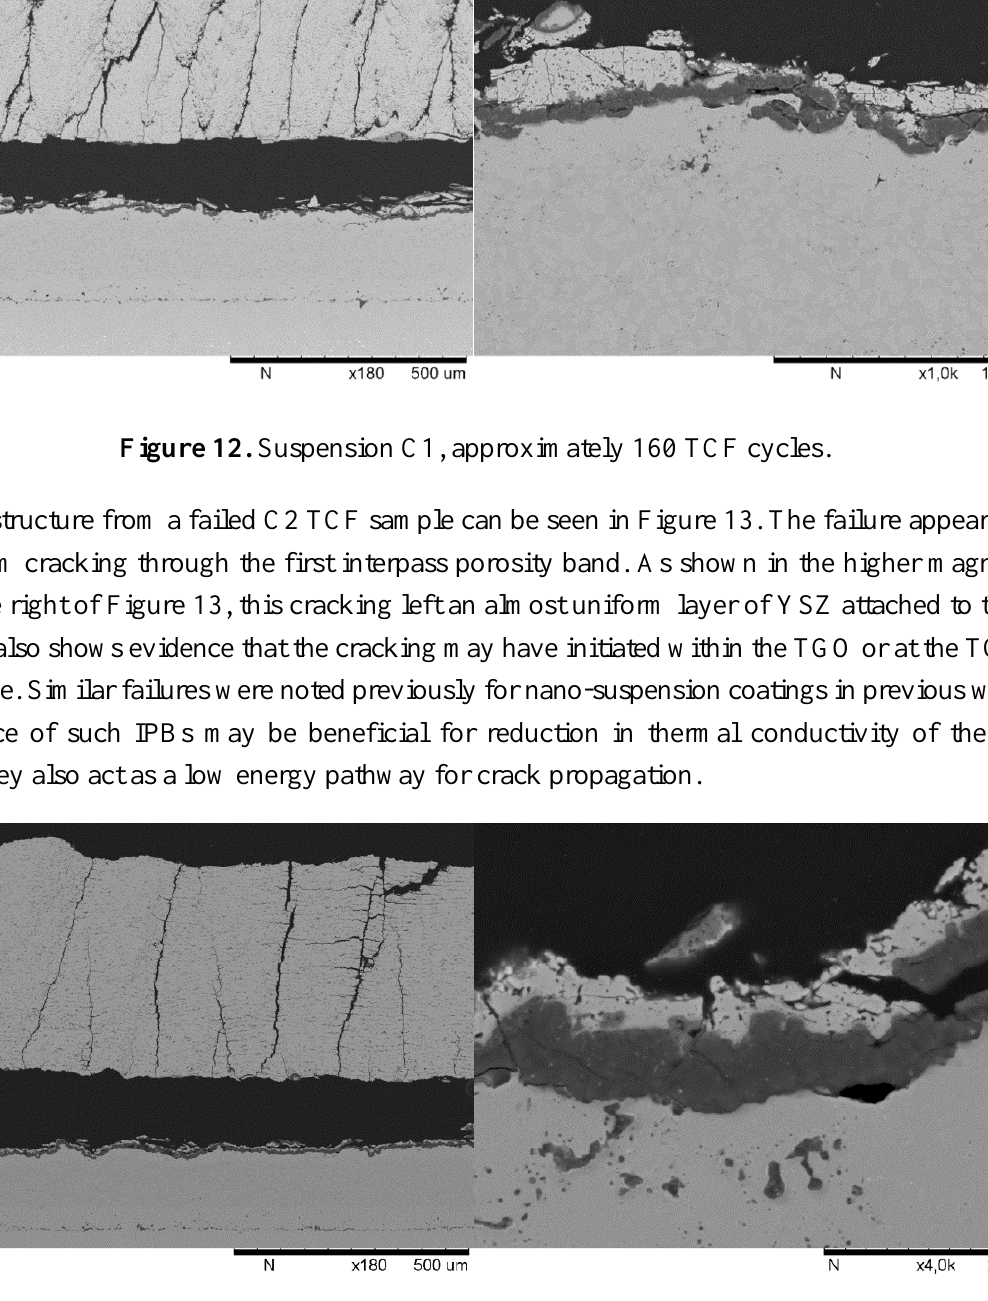
Figure 13. Coating C2, approximately 150